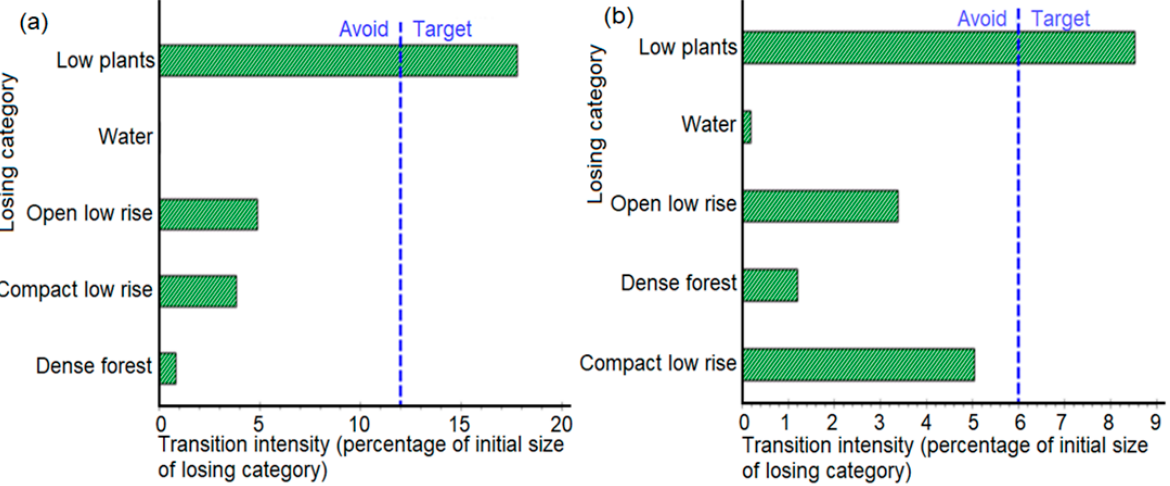
Figure 6. Transition intensity given the gain of Light weight low rise form ( a ) 1990 to 2005 and ( b ) 2005 to 2020.